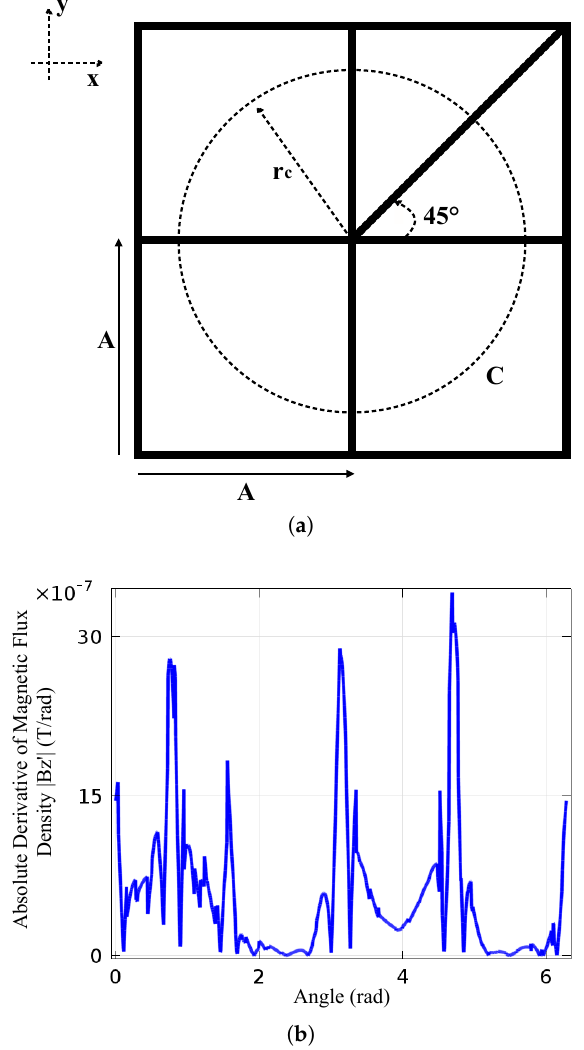
Figure 4. ( a ) Equally spaced grounding grid having diagonal branch. The angular displacement between a normal branch and a diagonal branch is 45 ◦ . ( b ) 1st order derivative of magnetic flux density on C. Inter influence sphere (peak width) space between peak at 0 rad, corresponding to branch position at 0 ◦ , and peak at 0.78 rad, corresponding to branch position at 45 ◦ , has reduced